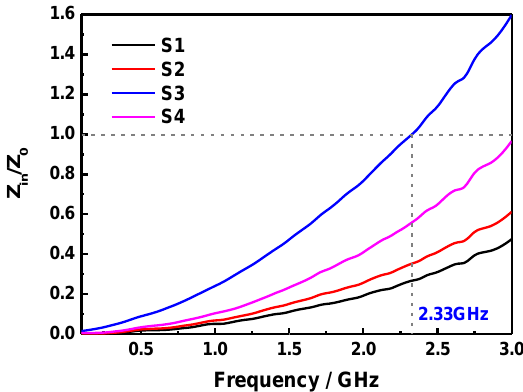
Figure 9. Frequency dependent Z in /Z 0 values of S1, S2, S3, and S4 at the thickness of 4 mm.